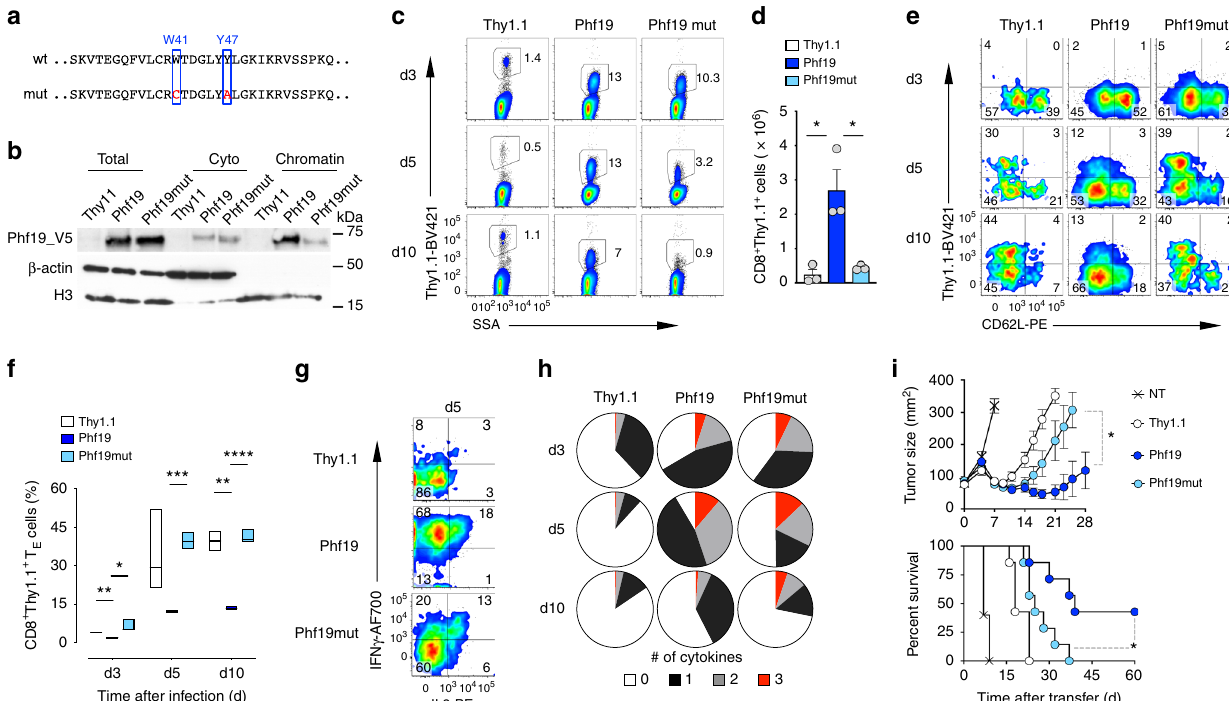
Fig. 7 Phf19 epigenetically reprograms T cell antitumor immunity. a Amino acid sequence alignment of the partial aromatic cage of Phf19. Tryptophan (W) and tyrosine (Y) residues were mutated to cysteine (C) or alanine (A), respectively. b Immunoblot of total, soluble, and chromatin-bound proteins from CD8 + T cells transduced with the Phf19Thy1.1, Phf19mutThy1.1, and Thy1.1 control. c Flow cytometry of splenic T cells at indicated time points following adoptive transfer of 3 × 10 5 pmel-1 CD8 + T cells transduced with Phf19Thy1.1, Phf19mutThy1.1, or Thy1.1 into wild-type mice in conjunction with gp100-VV. Numbers indicate percentage after gating on live CD8 + Thy1.1 + T cells. d Number of splenic pmel-1 CD8 + Thy1.1 + T cells 5 days after transfer as in c . Bars represent the mean ± s.e.m. of three individual mice. e Flow cytometry of splenic CD8 + Thy1.1 + T cells at indicated time points after transfer as in c . Numbers indicate percentage after gating on live CD8 + Thy1.1 + T cells. f Percentage of splenic pmel-1 CD8 + Thy1.1 + T E cells at indicated time points as in c . Data are presented as box plots extending to minimum and maximum values. Bands inside the boxes represent median values of three individual mice. g Intracellular cytokine staining of splenic CD8 + Thy1.1 + T cells 5 days after transfer as in c . Numbers indicate percentage after gating on live CD8 + Thy1.1 + T cells. h Combinatorial cytokine response of splenic CD8 + Thy1.1 + T cells as in c , as determined by the Boolean combination of gates identifying IFN- γ + , IL- 2 + , and TNF + cells. Data are presented as the mean of three individual mice. i Tumor size (left, mean ± s.e.m.) and survival curve (right) of B16 tumor- bearing mice receiving 2 × 10 6 cells generated as in c in conjunction with gp100-VV and IL-2 ( n = 7 mice/group). NT no treatment. Data are representative of two independent experiments. * P < 0.05; ** P < 0.01; *** P < 0.005; **** P < 0.001 (unpaired two-tailed Student ’ s t -test) ( d , h , and i left); * P < 0.05 (a Log- rank (Mantel-Cox) Test) ( i